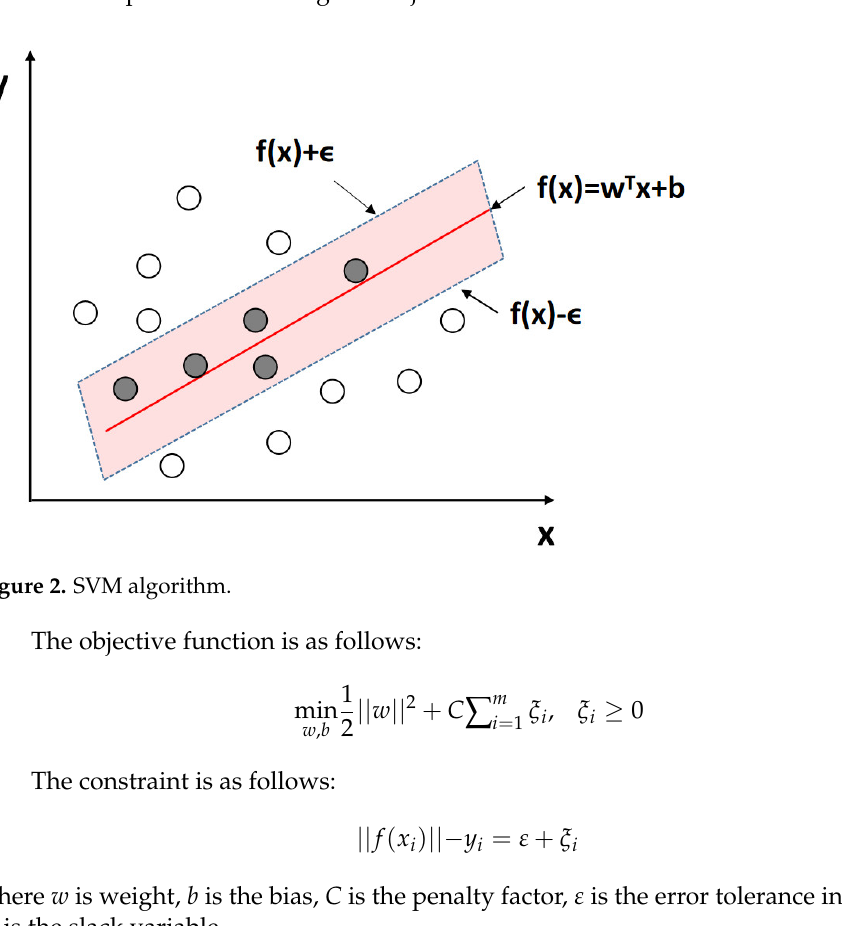
Figure 3. The random forest algorithm.